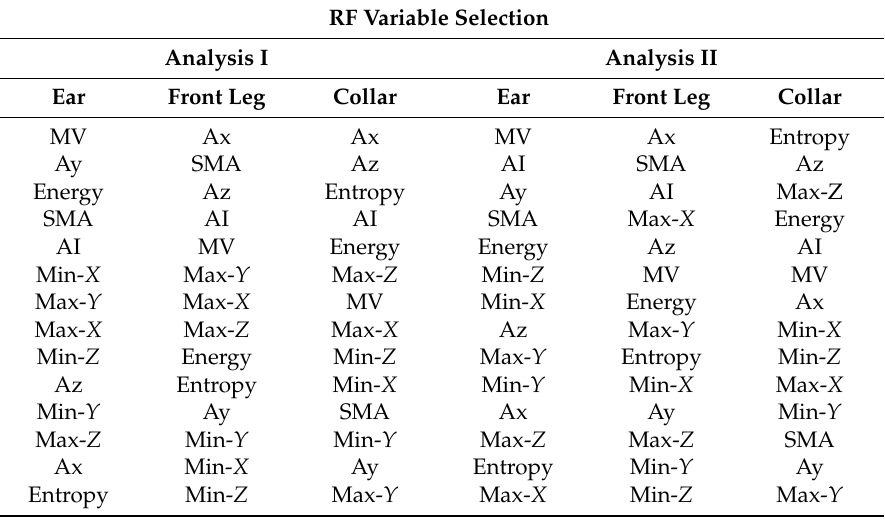
Table 4. The metric order of importance for each deployment (in decreasing order of importance).